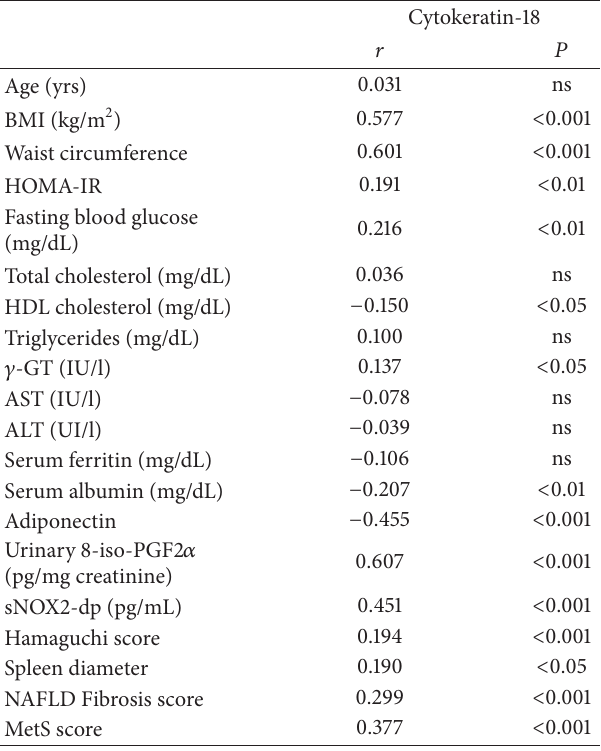
Table 3: Correlations between serum cytokeratin-18 and some clinical and metabolic